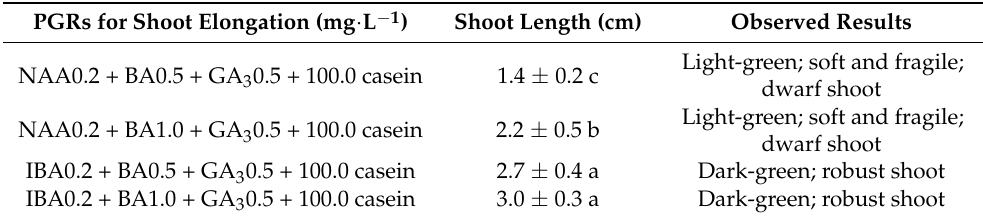
Table 3. Effect of plant growth regulators on shoot elongation of Sinningia hybrida ‘Isa’s